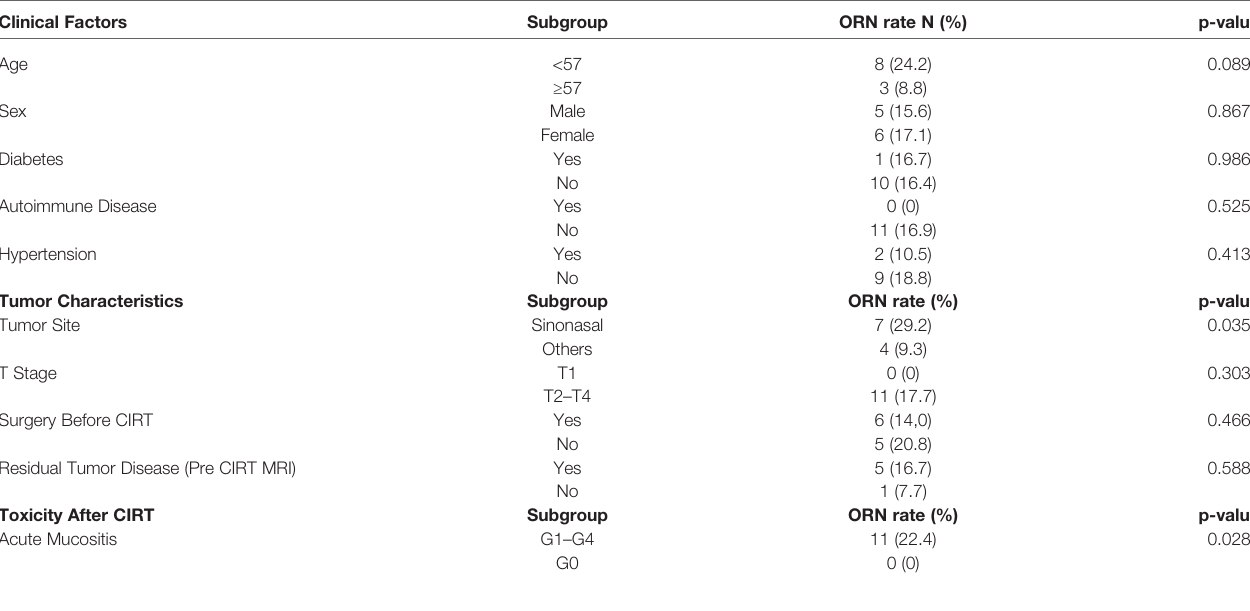
TABLE 2 | Correlation of relevant patients clinical and tumor characteristics and ORN at univariate analysis. Clinical